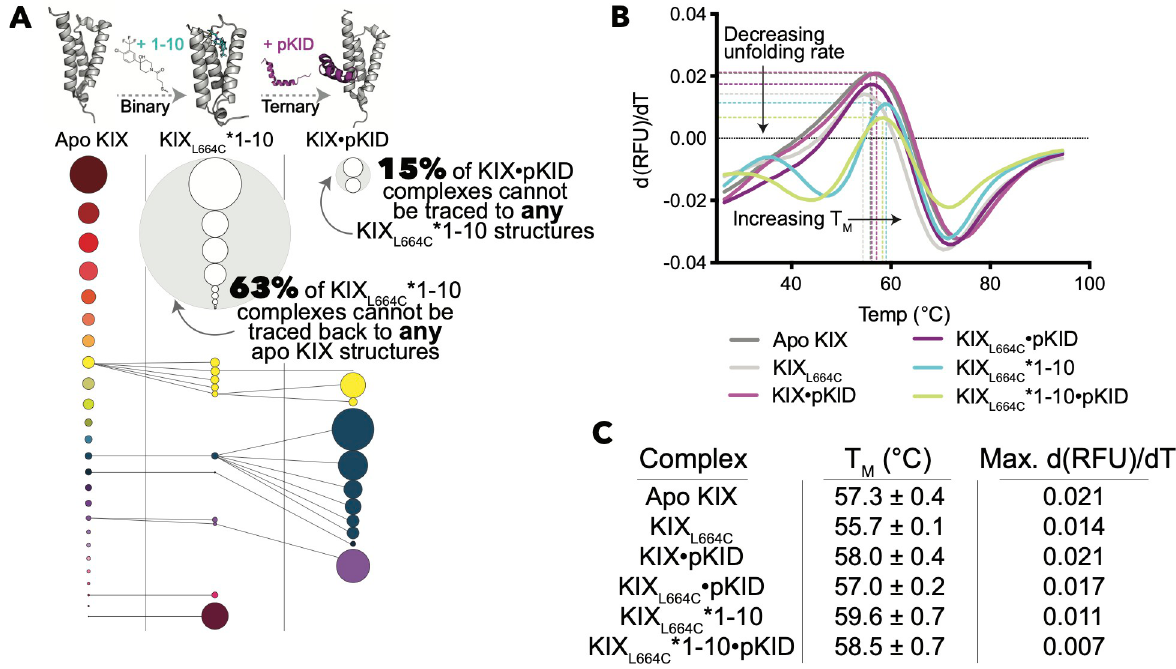
Fig 5. (A) Pathways of KIX conformational selection in the pKID system with allosteric modulators. Circles represent KIX micro-state basins that come from K-means clustering analysis, and the diameter of each circle is proportional to the relative population. Circle colors correspond to the cluster origin from the apo KIX distribution. The diminishing states pathways are shown for molecule 1–10 Tethered to KIX L664C . The gray dashed lines indicate that there are more steps involved in forming the complex than are depicted here (for instance, we did not perform MD on apo